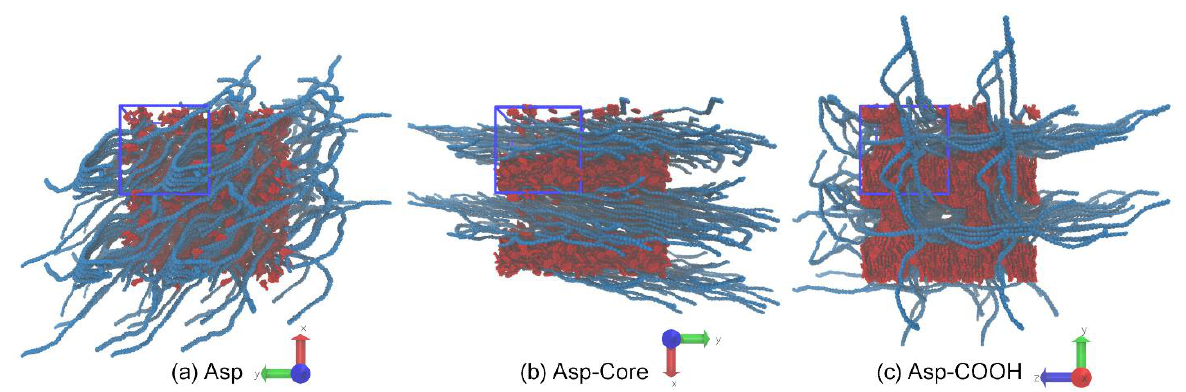
Figure 5. Typical snapshots of the mixture of asphaltenes (red) and P3HT (blue) obtained at the end of the 5 µs long simulation: ( a ) Asp, ( b ) Asp-Core and ( c ) Asp-COOH. Two periodic images in all directions are represented; the blue cube denotes the periodic simulation box. Aliphatic side groups are not represented for clarity.